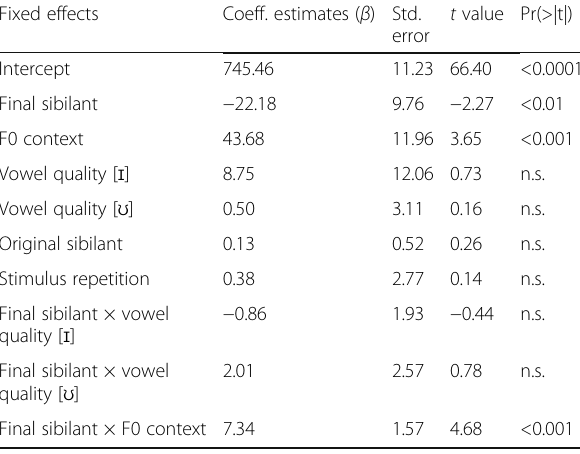
Table 5 Table of covariates, results summary of the linear mixed- effects